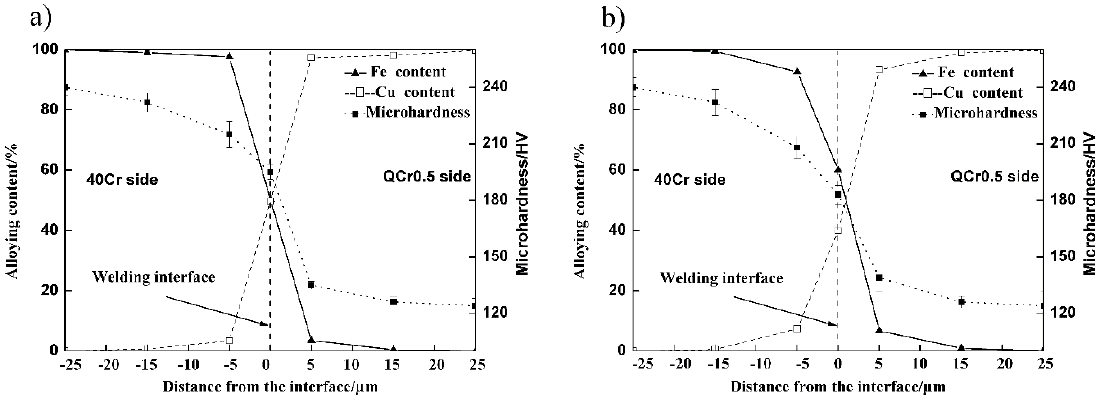
Figure 13. Micro-hardness and composition profiles across the 40Cr/QCr0.5 joint interface. ( T = 740 °C, t = 4 min, P 0 = 56.6 MPa, ε 0 = 1.5 × 10 − 4 s − 1 ). ( a ) E = 0 kV/cm, ( b ) E = 3 kV/cm.